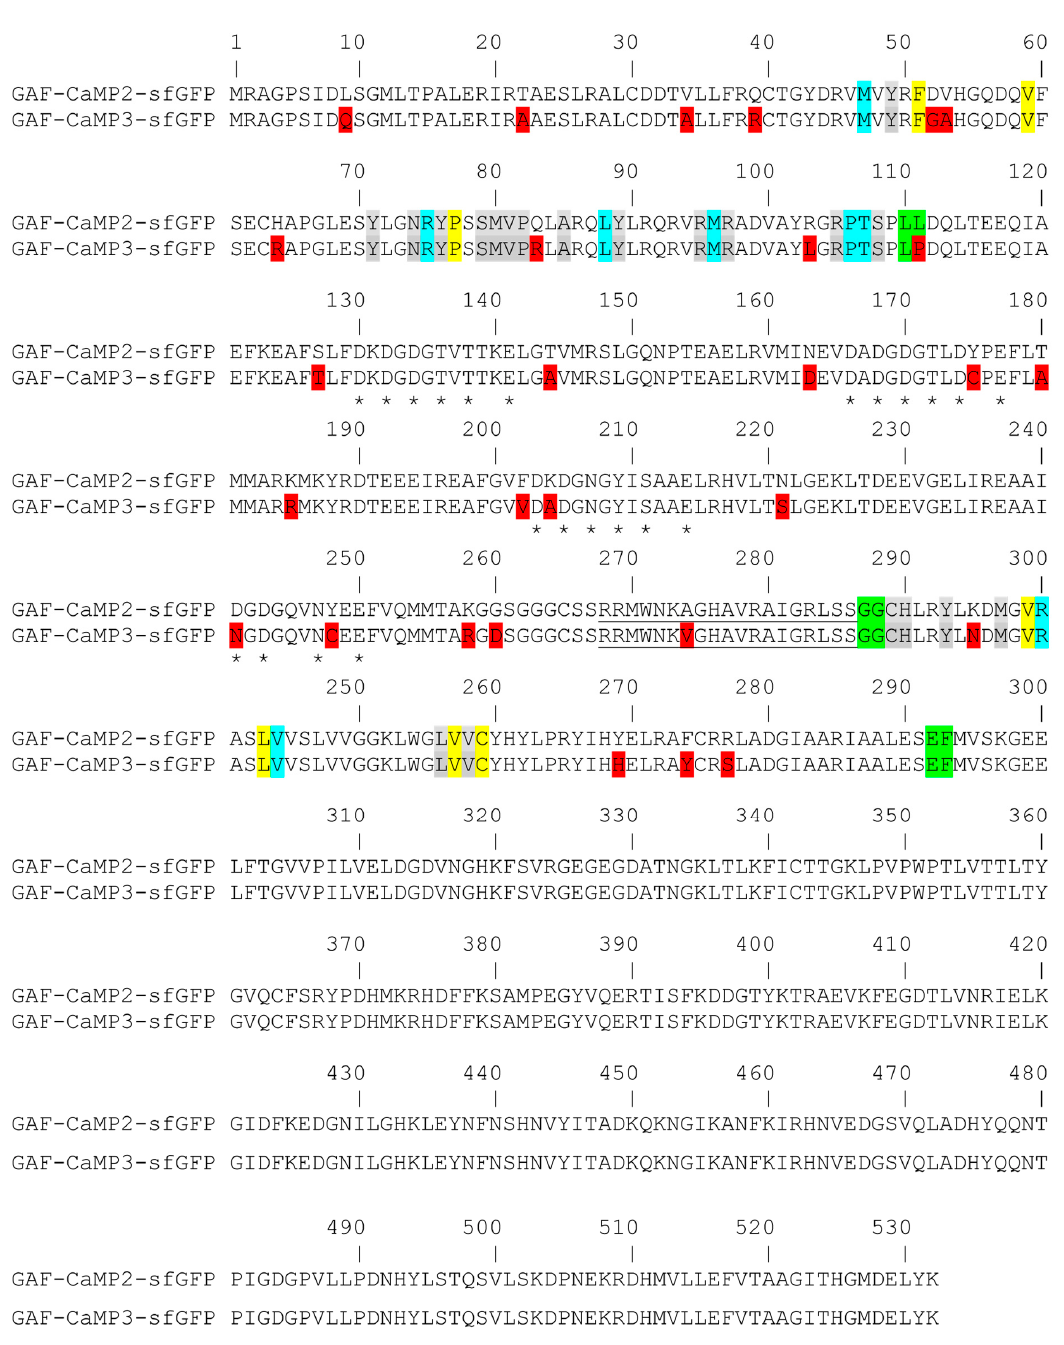
Figure 1. Alignment of the amino acid sequences for the GAF-CaMP3-sfGFP calcium indicator and its GAF-CaMP2–sfGFP progenitor. Alignment numbering follows that for the original GAF-CaMP2–sfGFP protein. Mutations in GAF-CaMP3–sfGFP related to the GAF-CaMP2–sfGFP progenitor, as well as the linkers between the fluorescent and calcium-binding domains, are highlighted in red and green colors, respectively. The residues within 4.5, 4.5–5.5, and 5.5–6.5 Å surrounding the biliverdin (BV) chromophore, as suggested according to the X-ray structure of PaBphP (PDB 3C2W), are highlighted in grey, cyan, and yellow colors, respectively. The residues in the CaM-part that assumed to bind Ca 2+ ions are indicated with stars (*). The M13 peptide is underlined.